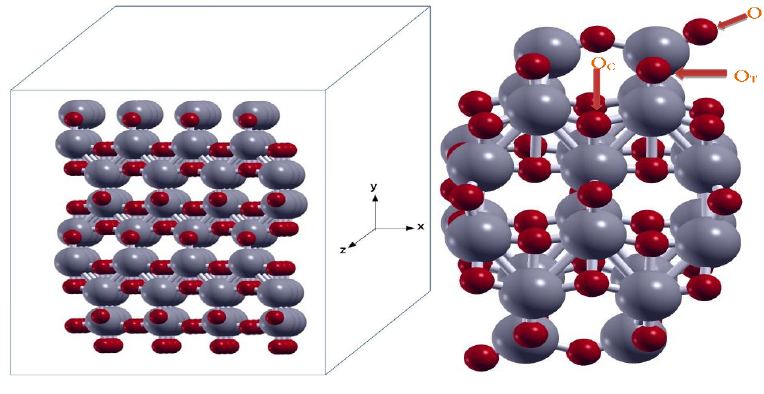
Fig. 1. (a): Representation of a 3×2×1 supercell of TiO anatase constructed from TiO unit cells along x, y and z directions and (b): Optimized struc- 2 2 ture of a pristine TiO anatase nanoparticle, OC: central oxygen; OT: twofold coordinated oxygen; OD: dangling 2